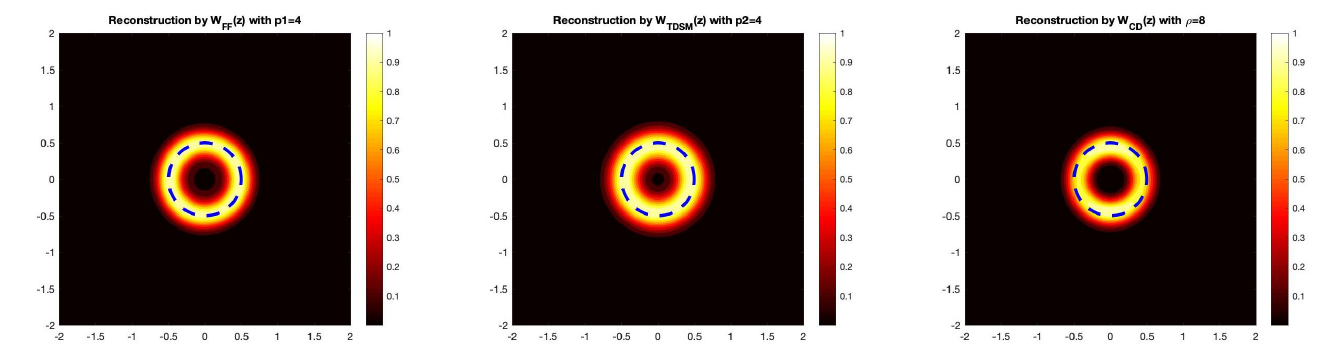
Figure 1. The reconstruction of the circular obstacle by the three direct sampling imaging functionals. In this example, we take δ = 0.05, which corresponds to a 5% noise level.